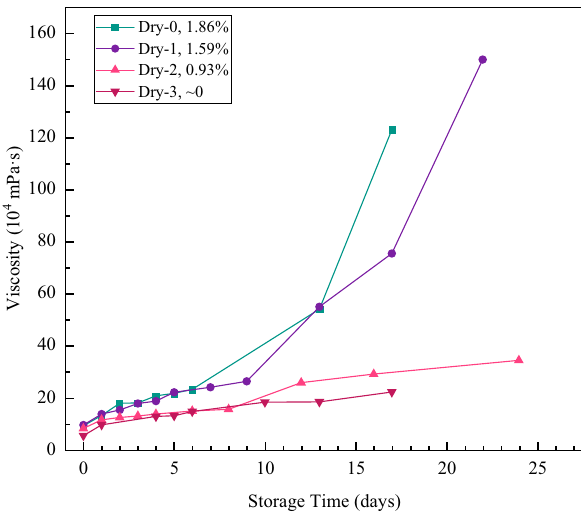
Figure 5: E ff ect of storage on the viscosity of HPDMS - fumed silica compositions with Aerosil R8200 silica containing di ff erent physi - cally adsorbed water content.